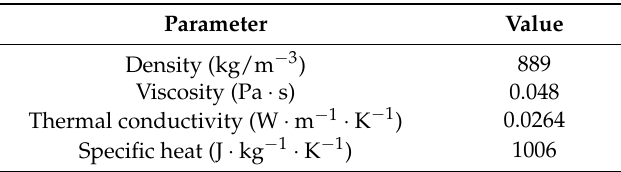
Table 3. Material’s properties.